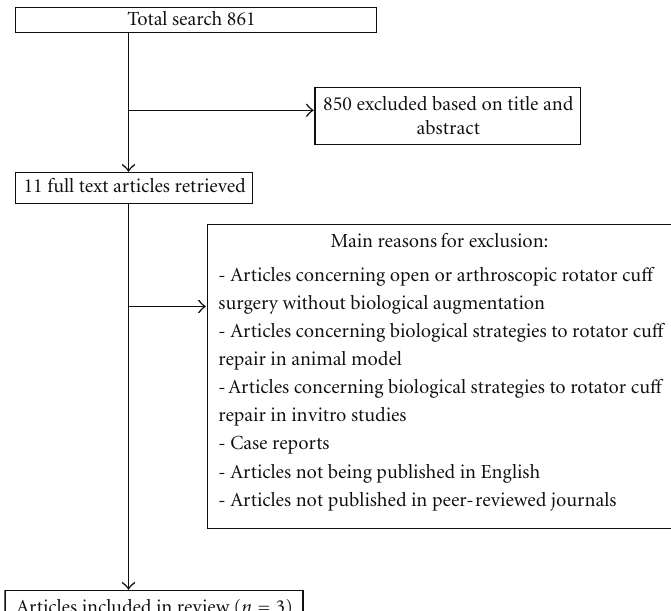
Figure 1: Flowchart of the search strategy and selection of